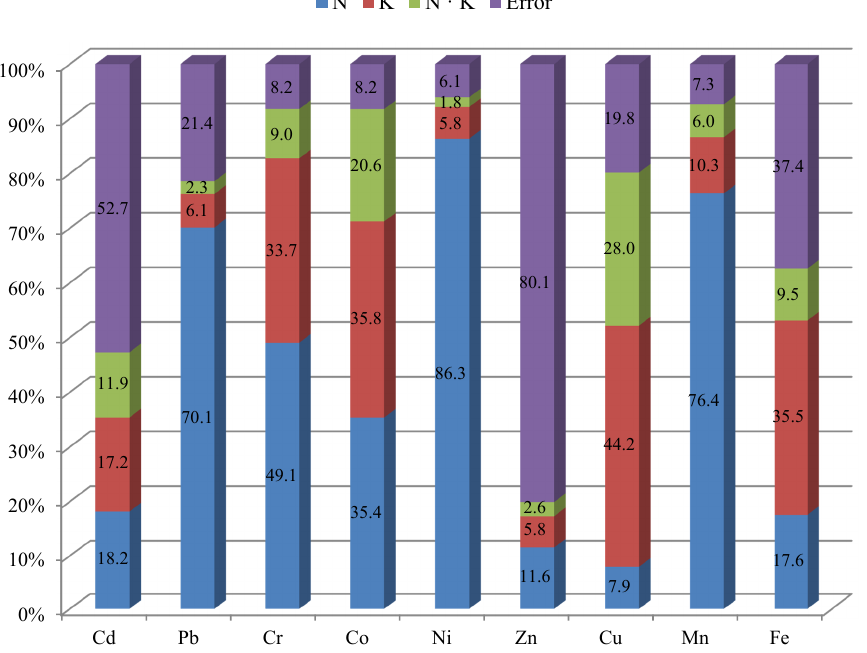
Figure 3. Per cent contribution of variable factors according to the content of trace elements in soil: N—Nitrogen dose, K—Potassium dose.